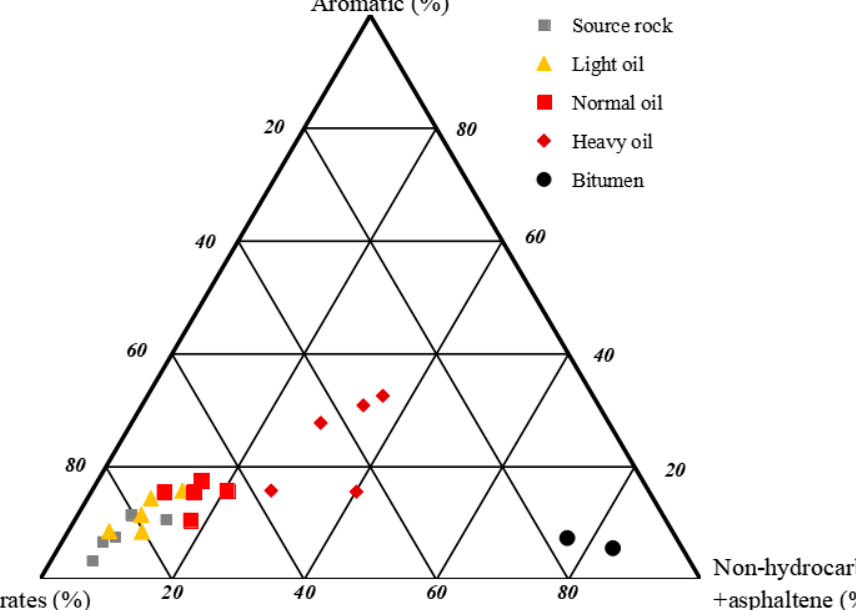
Figure 5. Triangles of group composition contents of crude oil samples in Wuerhe area, showing a decrease of the saturated hydrocarbon content and an increase of non-hydrocarbons and asphaltene contents from Permian source rocks to Cretaceous bitumen.